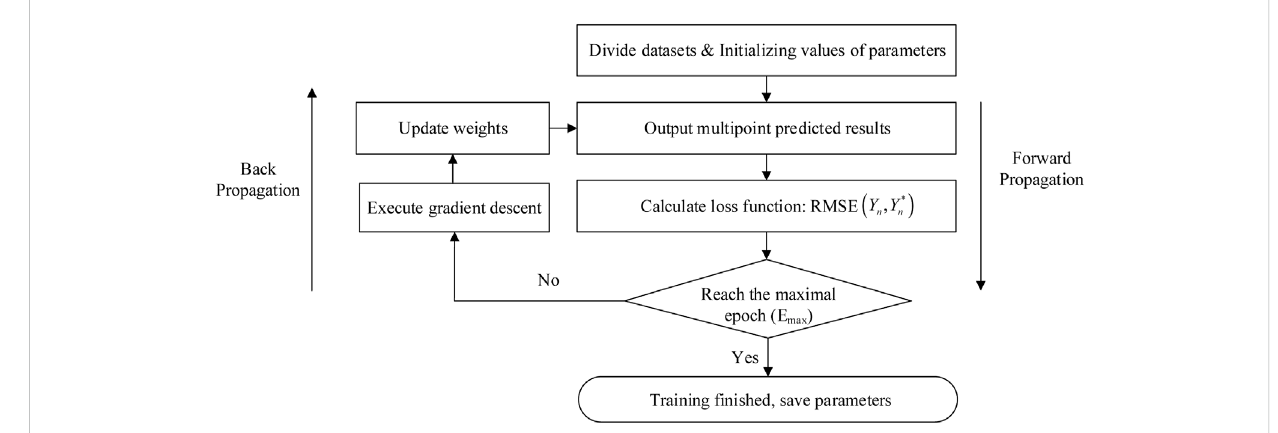
FIGURE 3 Flow chart of the MPM training process.